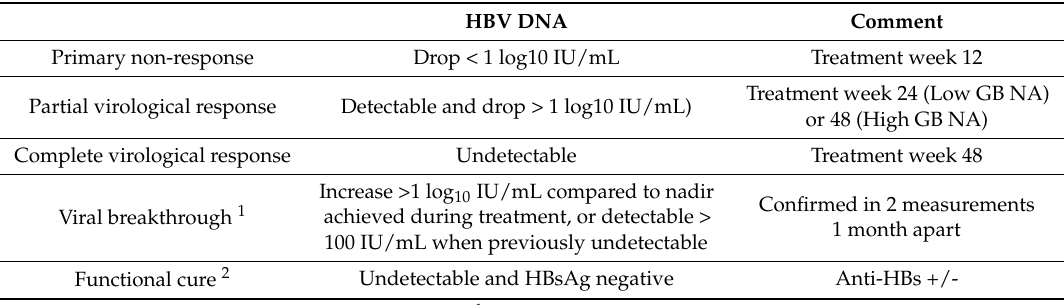
Table 2. HBV virological on treatment monitoring and evaluation of